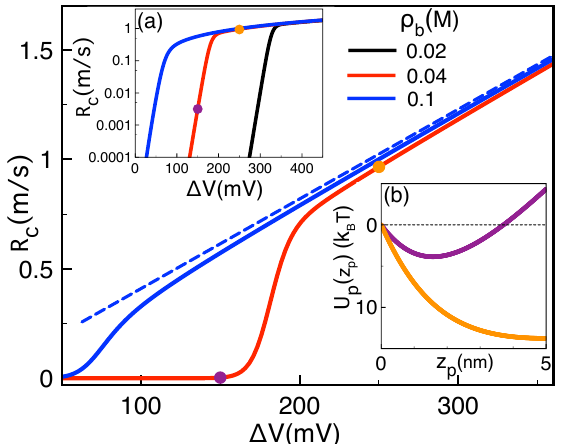
Figure 7. Main plot: Polymer capture rate R c (solid curves) and drift velocity v dr (dashed curve) against external voltage ∆ V at the salt concentration values indicated in the legend. Insets: ( a ) The curves of the main plot shown on a logarithmic scale and ( b ) the polymer potential U p ( z p ) at ∆ V = 150 mV (purple) and 250 mV (orange). The other parameters are the same as in Figure